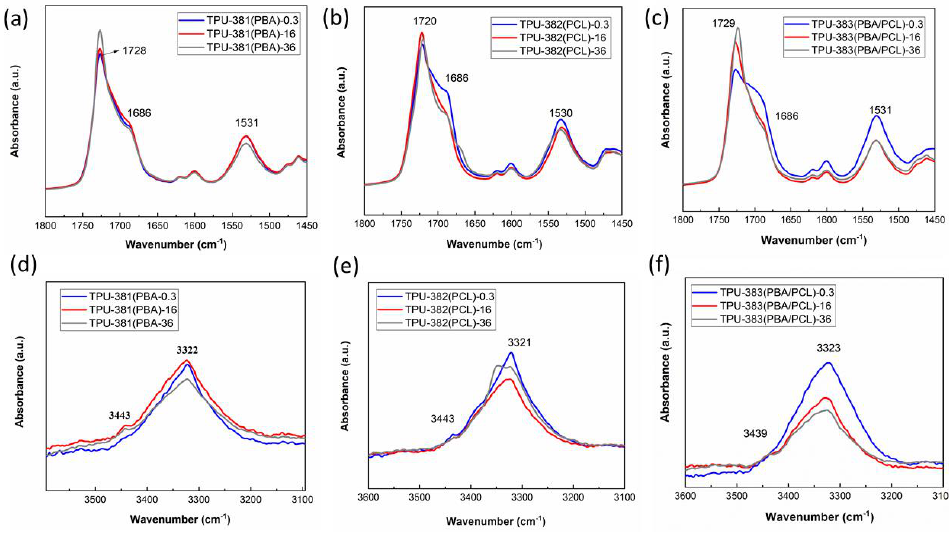
Figure 5. Infrared spectra of the TPU-381(PBA) ( a , d ), TPU-382(PCL) ( b , e ) and TPU-383(PBA/PCL) ( c , f ) in the region of stretching vibrations of carbonyl ( a – c ), amide groups ( d – f ). For TPU-382(PCL)-0.3 the second derivatives allow to select the following absorption bands: 1686, 1708, 1721, 1732 and 1740 cm − 1 (Figure S4b, Table S3). On the one hand, high